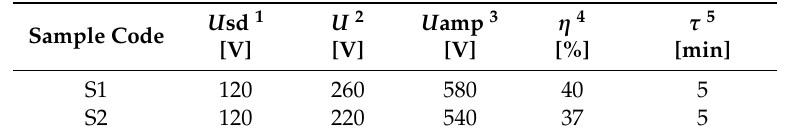
Table 1. Sample codes and oxidation conditions during plasma electrolytic oxidation of 316L samples in aluminate